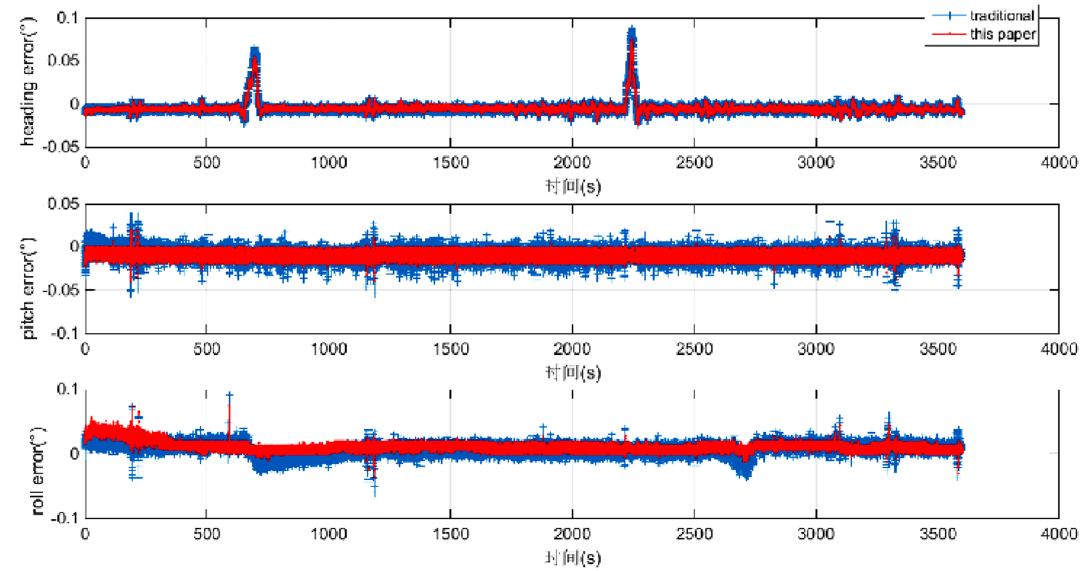
Figure 7. Attitude error comparison.